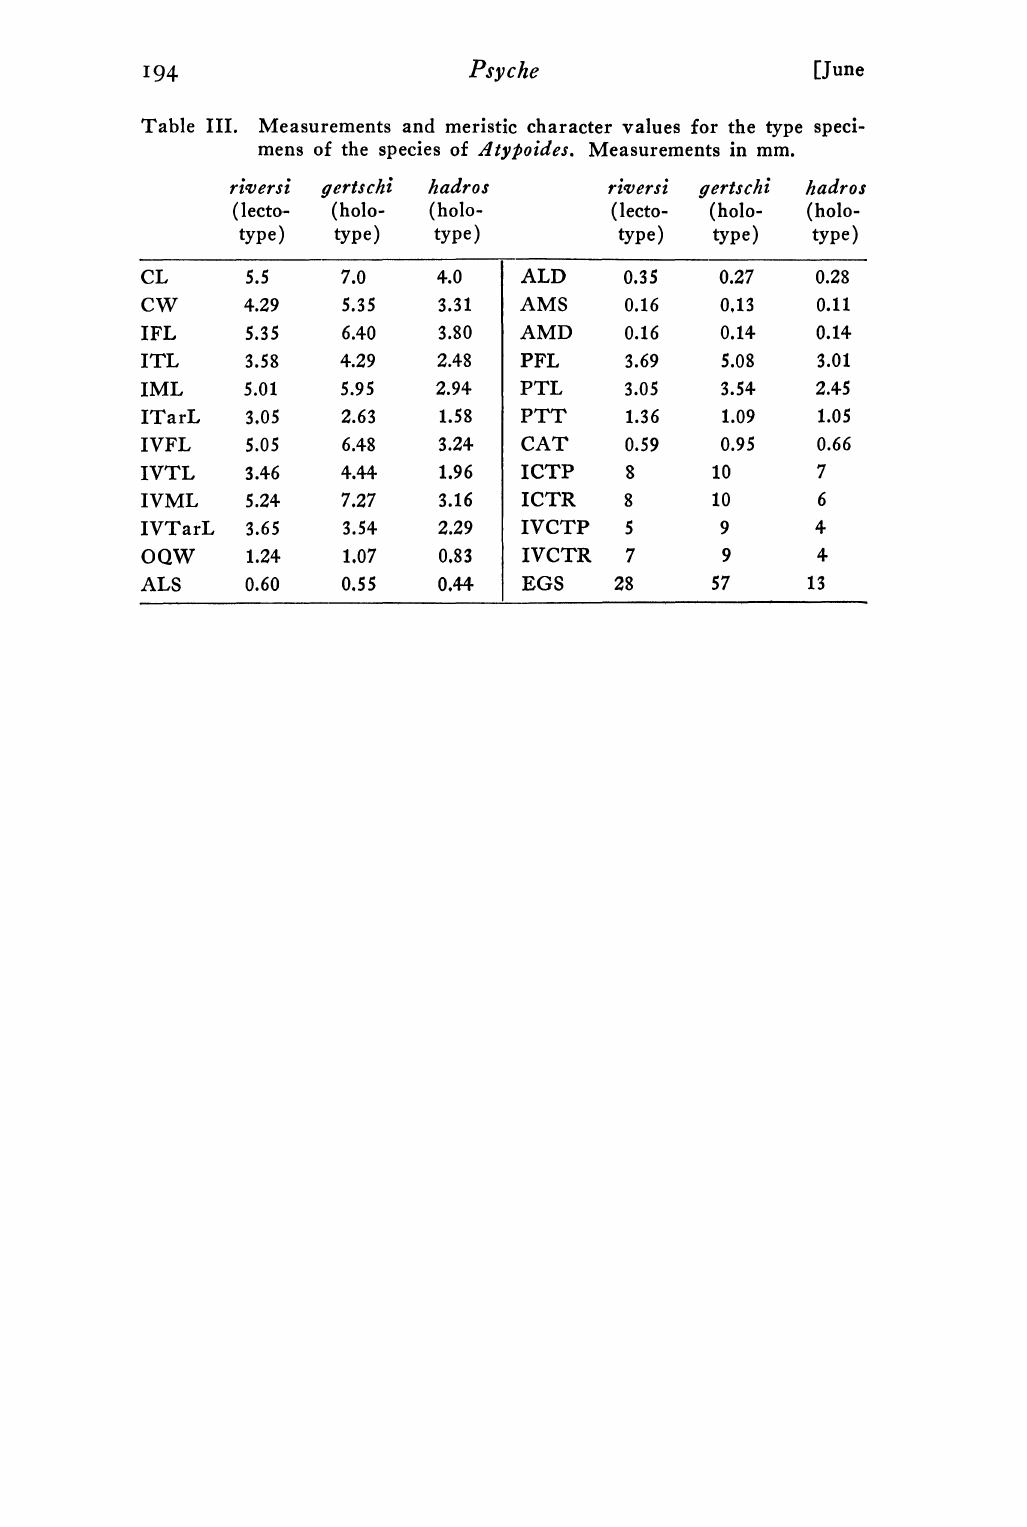
Table III. Measurements and meristic character values for the type speci- mens of the species of dtyoides. Measurements in mm. riersi tzertschl hadros riqaersi gertschi hadros (leeto- (holo- (holo- (leeto- (holo- (holo- type) type) type) type) type) type)